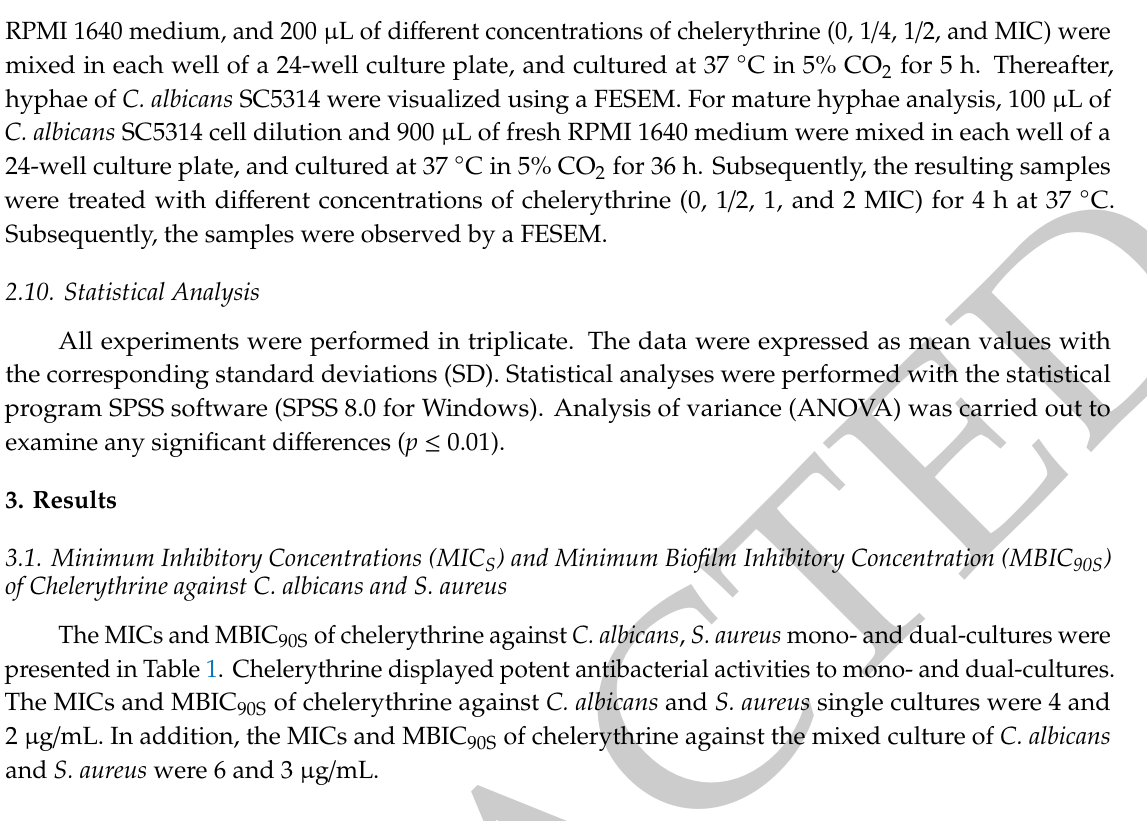
Table 1. Minimum Inhibitory Concentrations (MIC)s and Minimum Biofilm Inhibitory Concentration (MBIC 90S ) of chelerythrine against mono- and dual-species planktonic cells of Candida albicans and Staphylococcus aureus